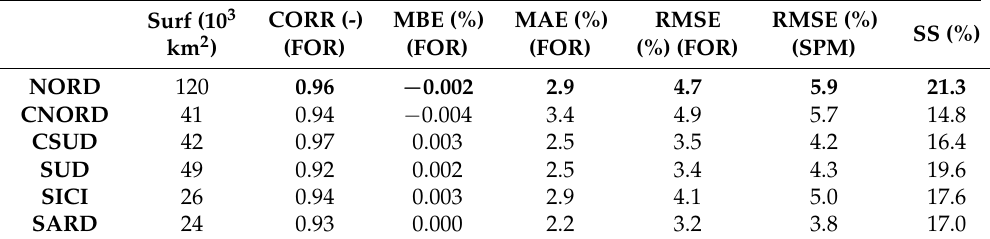
Table 5. Load forecast accuracy metrics of the ANN blending (FOR), and RMSE of smart persistence forecast (SPM) obtained on the six market zones. MBE, MAE, RMSE are in percent of the peak load. In bold is the area for which the greatest improvement over SPM was achieved. MBE, MAE, RMSE are in percent of the peak load.